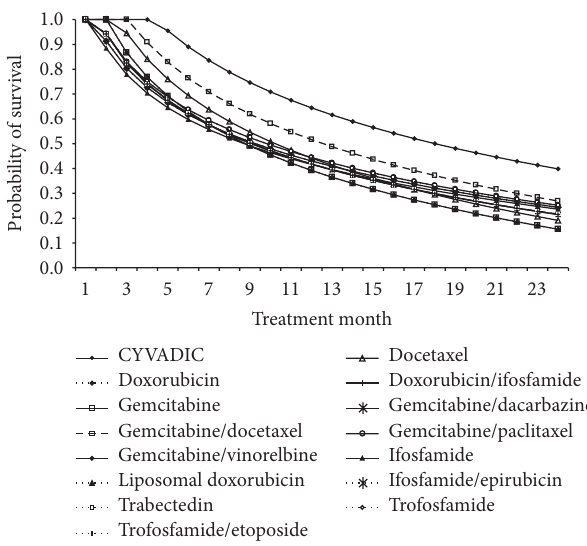
Figure 3: Survival rates associated with second-line